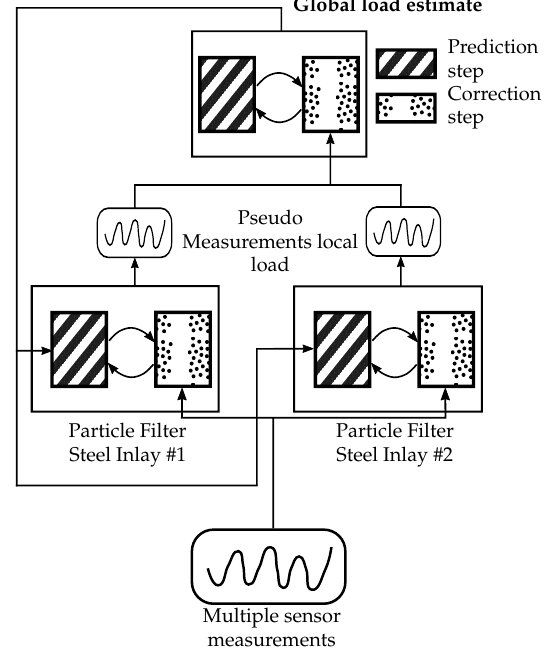
Figure 12. Block diagram of the employed estimator system for basic sensor fusion and load estimation.